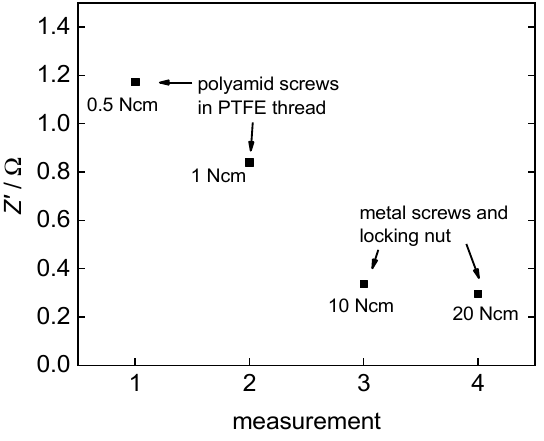
Figure 7. E ff ect of clamping pressure on the examined resistance of 3M 825 EW membrane. Figure 7. Effect of clamping pressure on the examined resistance of 3M 825 EW membrane.